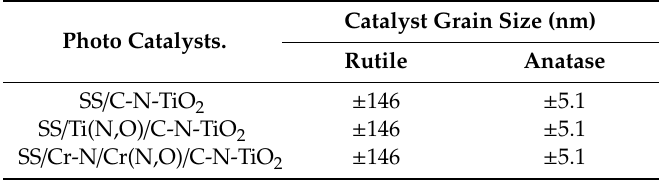
Table 2. Particle sizes of C-N-TiO 2 coated on SS, SS / Ti (N,O) and SS / Cr-N / Cr (N,O) anticorrosion meshes calculated from XRD analysis using the Scherrer equation ( n = 2). Photo Catalysts.